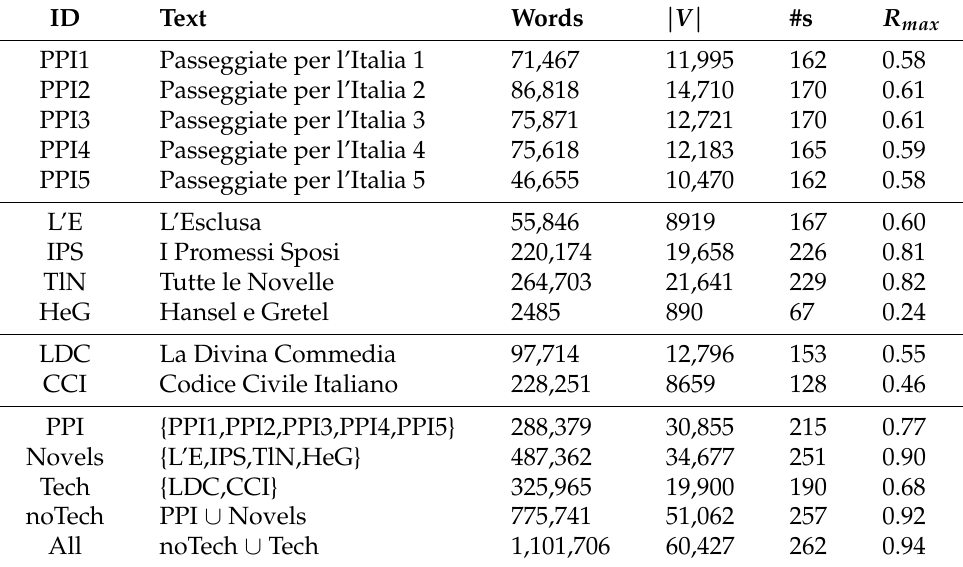
Table 2. Italian corpus.